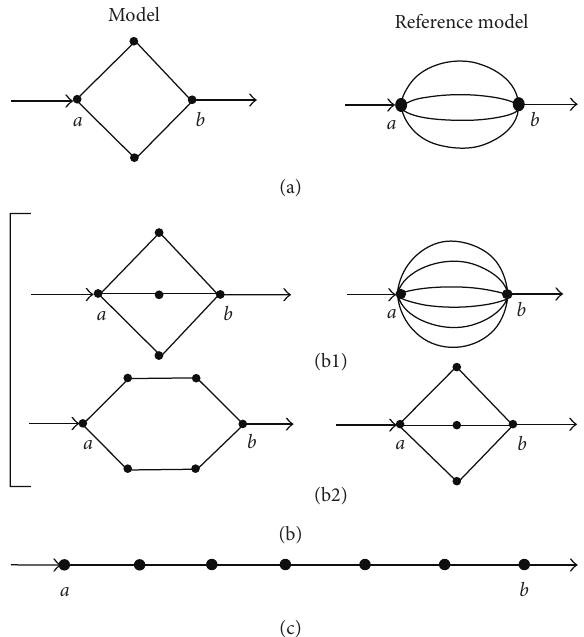
Figure 2: Diagrams of solute diffusion between “ 𝑎 ” and “ 𝑏 ”: two models with four transitions (a), multipath models with six transitions (b), and a single-path model with six transitions (c). In each case, the “reference models” are employed to derive expressions for the diffusion coefficients of the “models” (see main